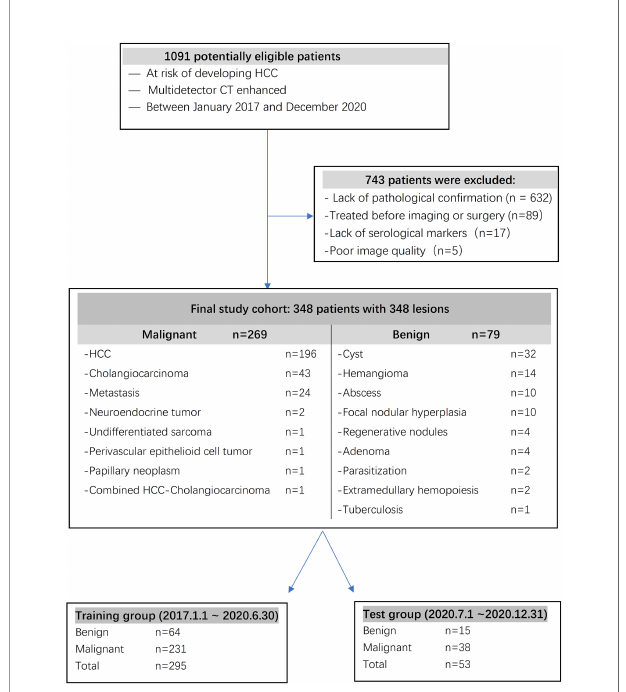
FIGURE 1 | Flowchart illustrating subject